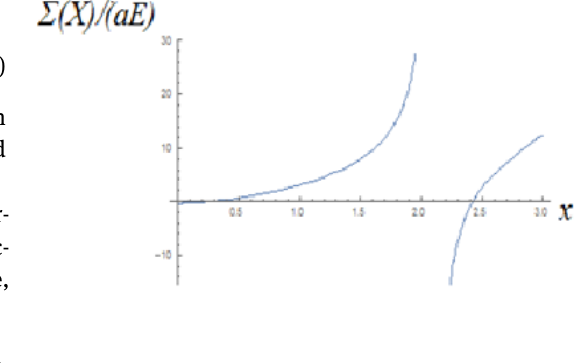
Figure 5: The distribution of stresses in the Λ -space with respect to the initial x axis